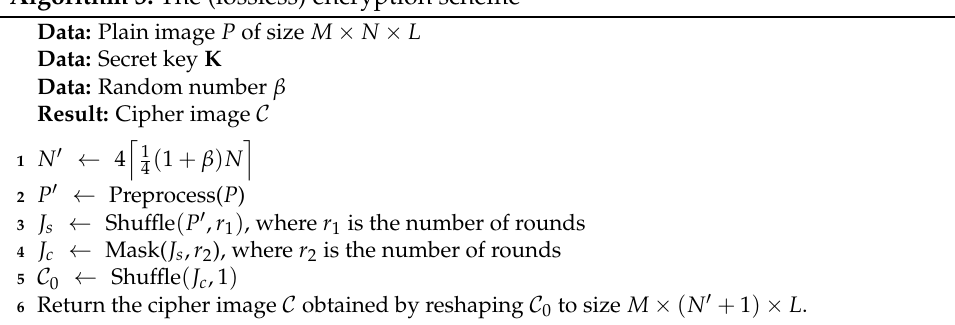
Algorithm 3: The (lossless) encryption